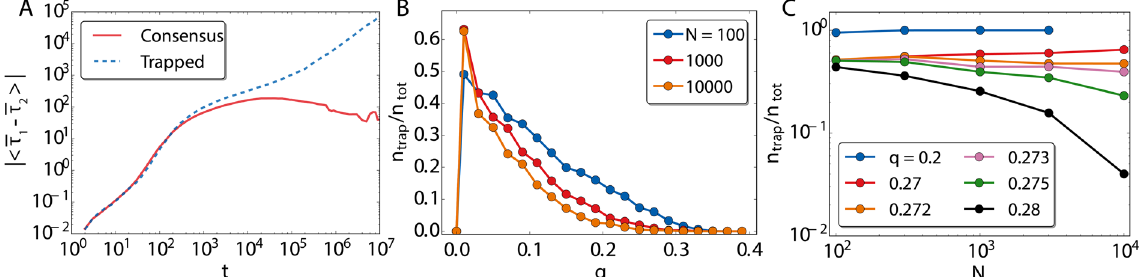
Figure 5. In ( A ) difference of average persistence times as a function of time for those realizations that reach the global consensus state and those that remaining trapped, employing N = 1000 and q = 0.1 and averaging over 1000 realizations. In ( B ) the fraction of trapped configurations as a function of q . Each point is computed over 1000 realizations. Note the singularity of q = 0, in which there is no possibility of trapping since the layers are disconnected and their own evolution is always a coarsening process to consensus. In ( C ) the fraction of trapped configurations as a function of N for several values of q . Each point calculated over 1000